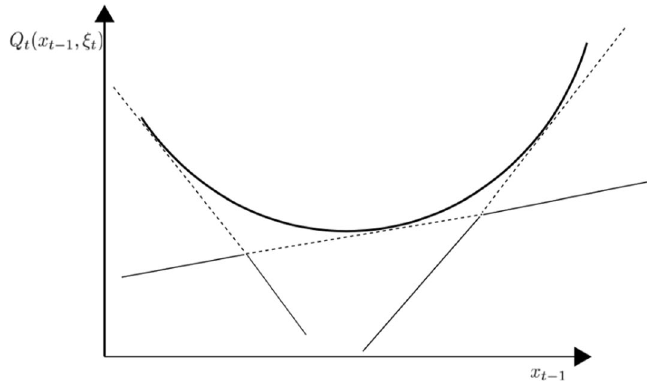
Fig. 1 Linear approximations (dashed lines) of the exact value of function